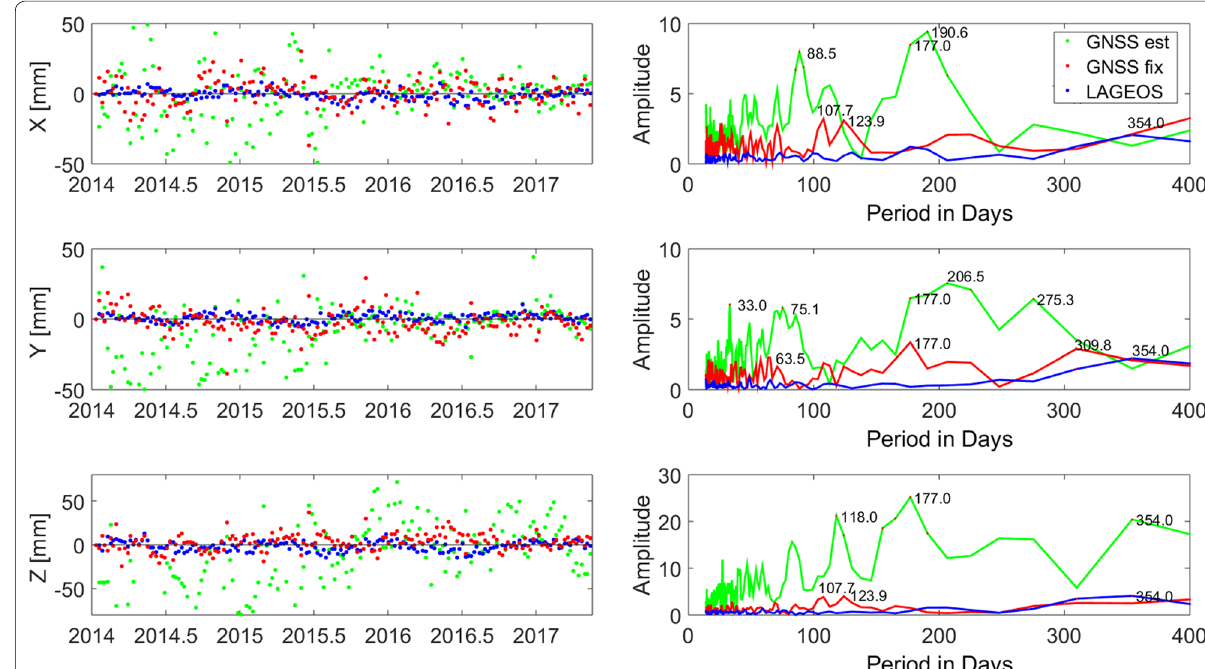
Fig. 6 Geocenter coordinates from LAGEOS-1/2 (Solution 5, blue), GNSS-only with estimated parameters (Solution 1, green), and GNSS-only with fixed orbits (Solution 2,